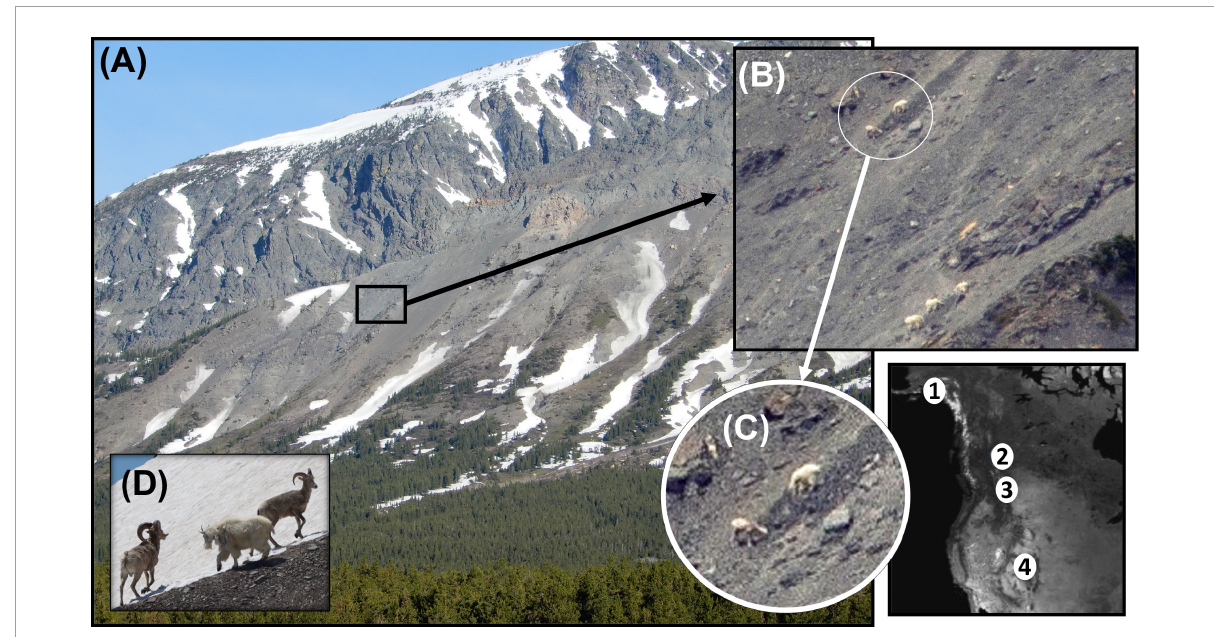
FIGURE3 Mountain goat-bighorn sheep contests at alpine sites in Glacier National Park, MT. (A) Remnant snowfield and mineral lick with (B) three goats (lower right central) and single goat and single female bighorn top left at water-saturated mineral lick, (C) sympatric feeding prior to goat displacement of bighorn (enlarged), and (D) male goat with actionable horn threat displacing two male bighorn. Inset reflects four sites of known displacements between mountains goats and (1) Dall sheep ( Ovis dalli ) in Alaska (Klein, 2019), and bighorn sheep at (2) Caw Ridge, Alberta, Canada (3) Glacier National Park, MT, and (4) Mt. Evans,